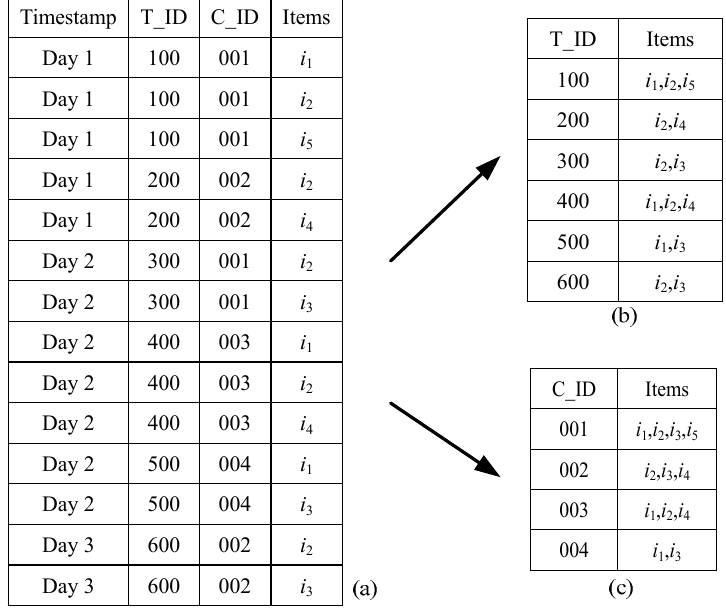
Figure 2. ( a ) Purchase database, ( b ) transaction based dataset, ( c ) customer based dataset.